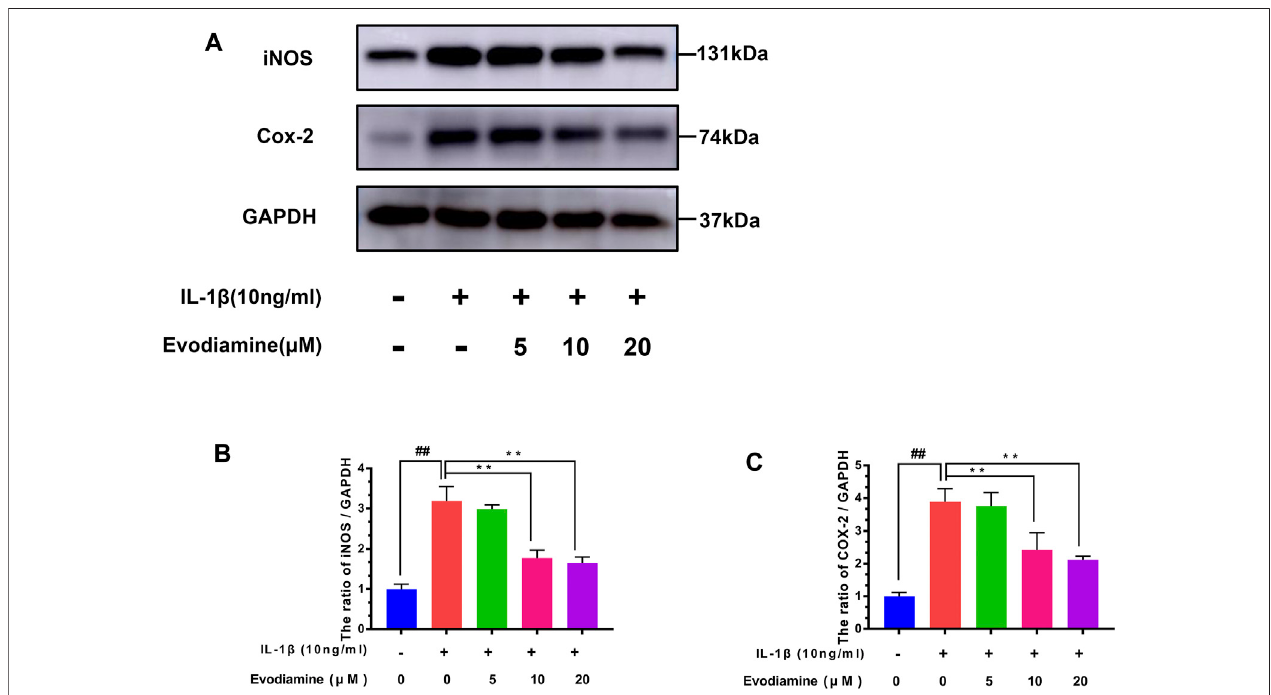
FIGURE3| EffectsofevodiamineonIL-1 β – inducedin fl ammation inmousechondrocytes. (A,B,C) Levelofexpression ofcyclooxygenase-2(COX-2) andinducible nitric oxide synthase (iNOS) in chondrocytes of the three groups were evaluated by Western blot. The data were expressed as mean ± SD. Signi fi cant differences between different groups are indicated as ## p < 0.01, vs. control group; pp p < 0.01, vs. IL-1 β alone stimulation group, n =